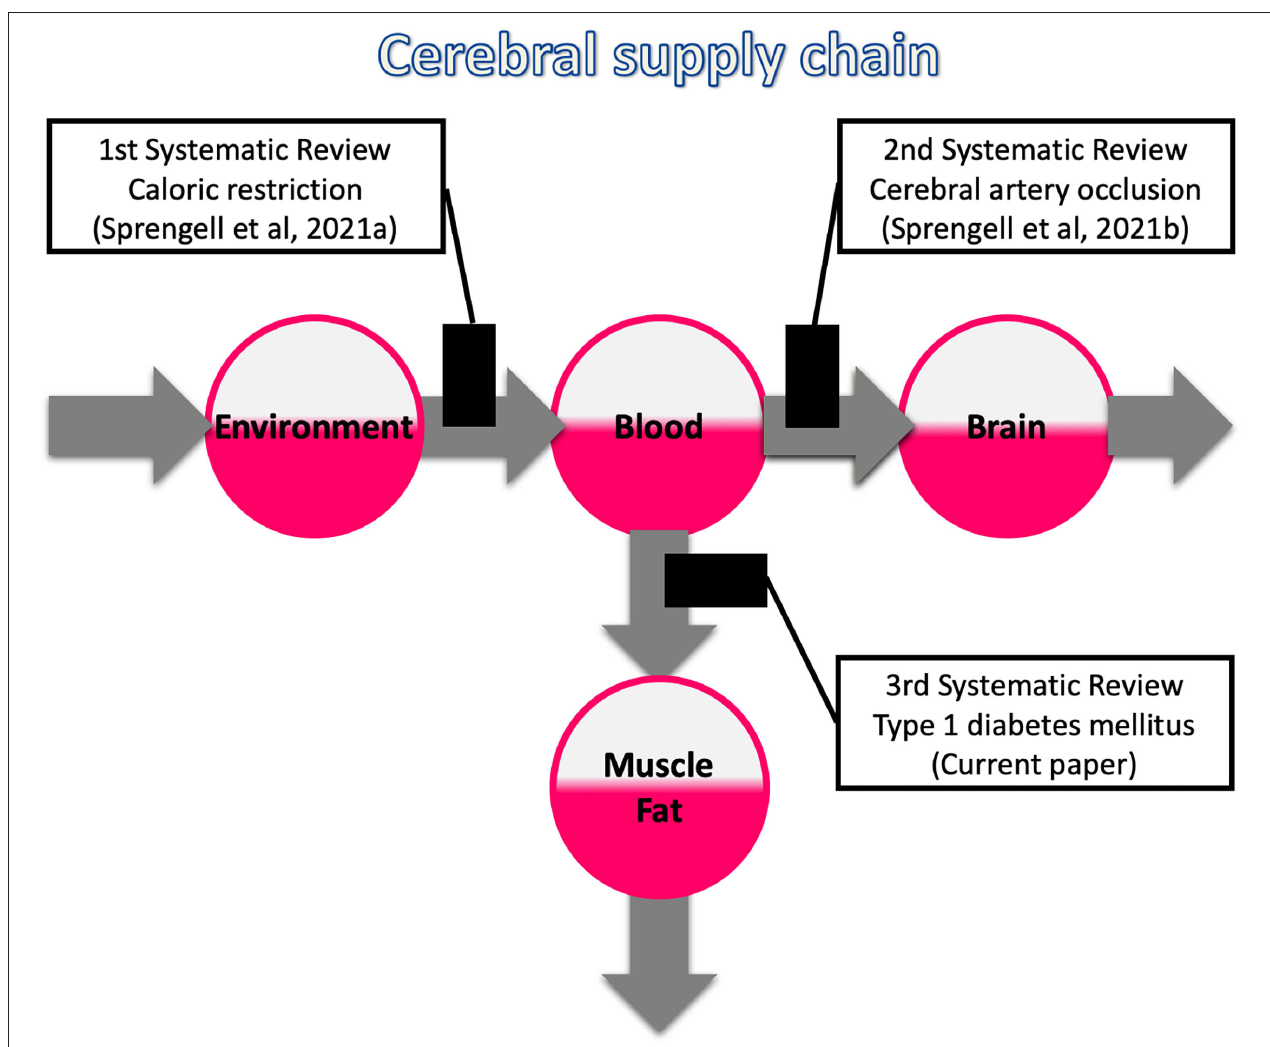
FIGURE 1 | Systematic reviews on the three possible bottlenecks within the cerebral supply chain. The first review deals with a distal bottleneck, i.e., caloric restriction (Sprengell et al., 2021a); the second one, deals with a proximal bottleneck, i.e., cerebral artery occlusion (Sprengell et al., 2021b); the third one, the current work, deals with a peripheral bottleneck, i.e., type 1 diabetes